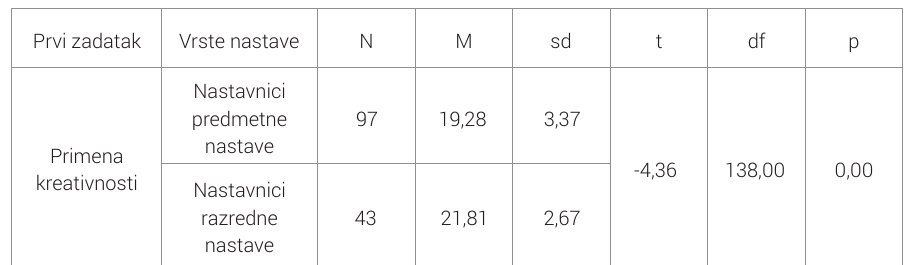
Tabela 2: Primena kreativnosti na časovima Table 2 / Apply creativity to classes